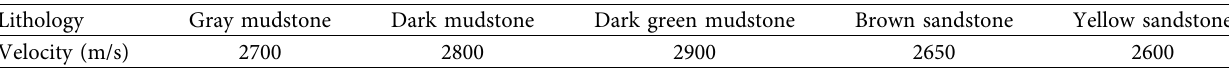
Figure 3: 2D channel geological model with lower interference. Table 1: Longitudinal wave velocities of different mudstones and